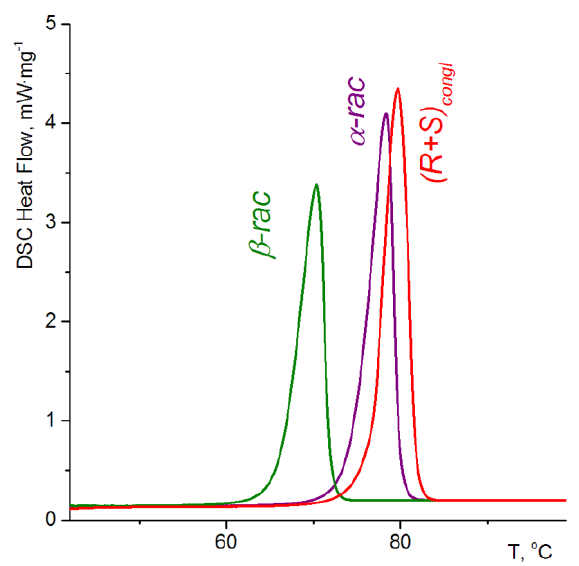
Figure 3. DSC traces of an equilibrium racemic sample identified as a conglomerate (red curve), a racemic sample obtained by crystallization from melt at 72 °C (violet curve), and crystallization from melt upon rapid cooling to 20 °C (olive curve). Sample weight ~ 8 mg.